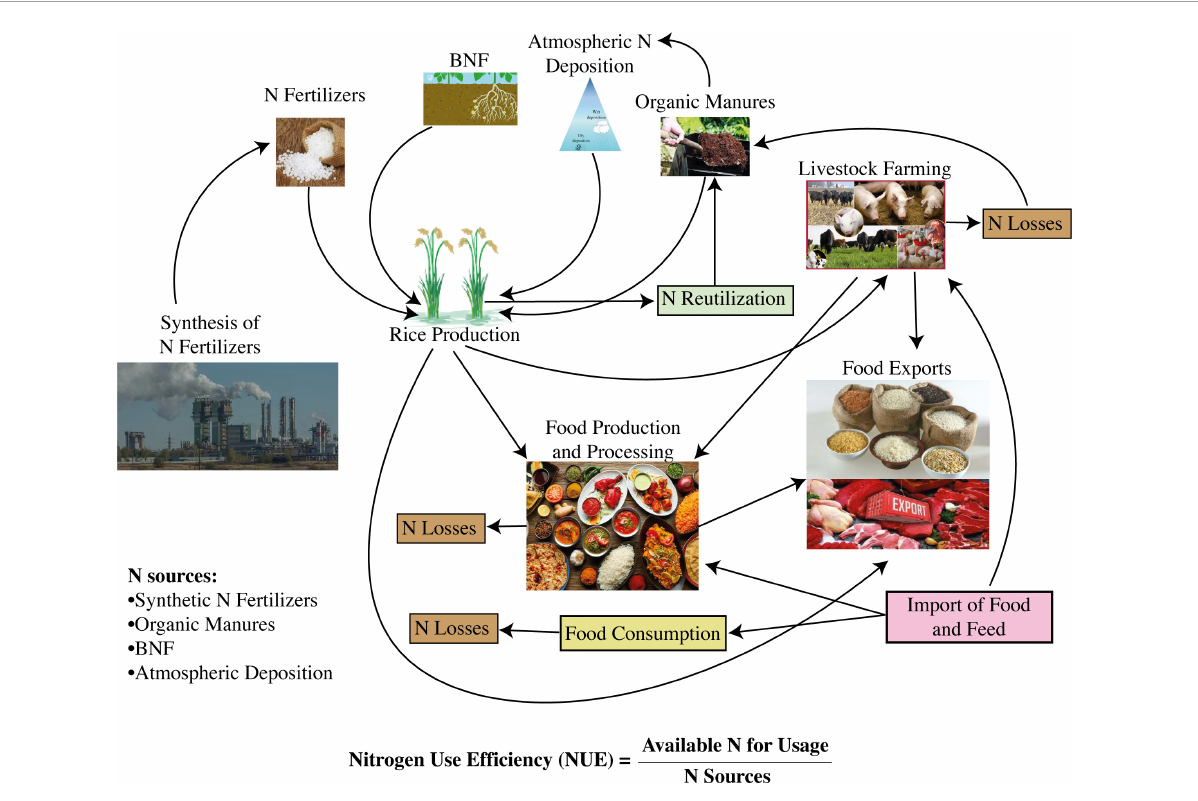
FIGURE3 An embedded approach indicating nitrogen-use efficiency in food production and consumption system (Source: Lassaletta et al., 2016; Erisman et al.,